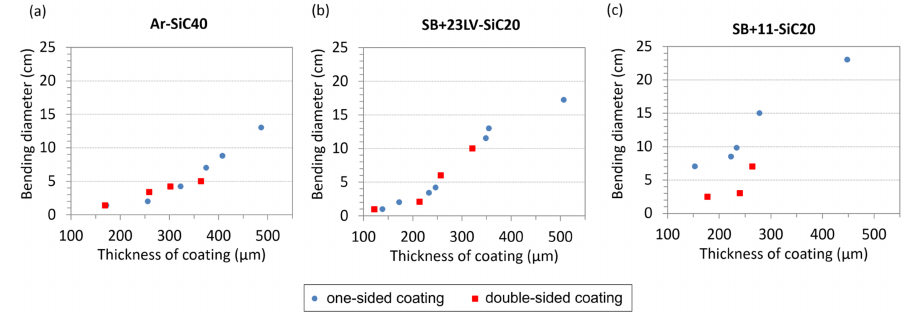
Figure 7. Dependence of minimal bending diameter, at which no damage was observed, on coating thickness found out by bending tests of Hastelloy / Ag tapes with ( a ) Ar-SiC20, ( b ) SB + 23LV-SiC20, and ( c ) SB + 11-SiC20 coating applied on one (blue circles) or both sides (red squares) of the